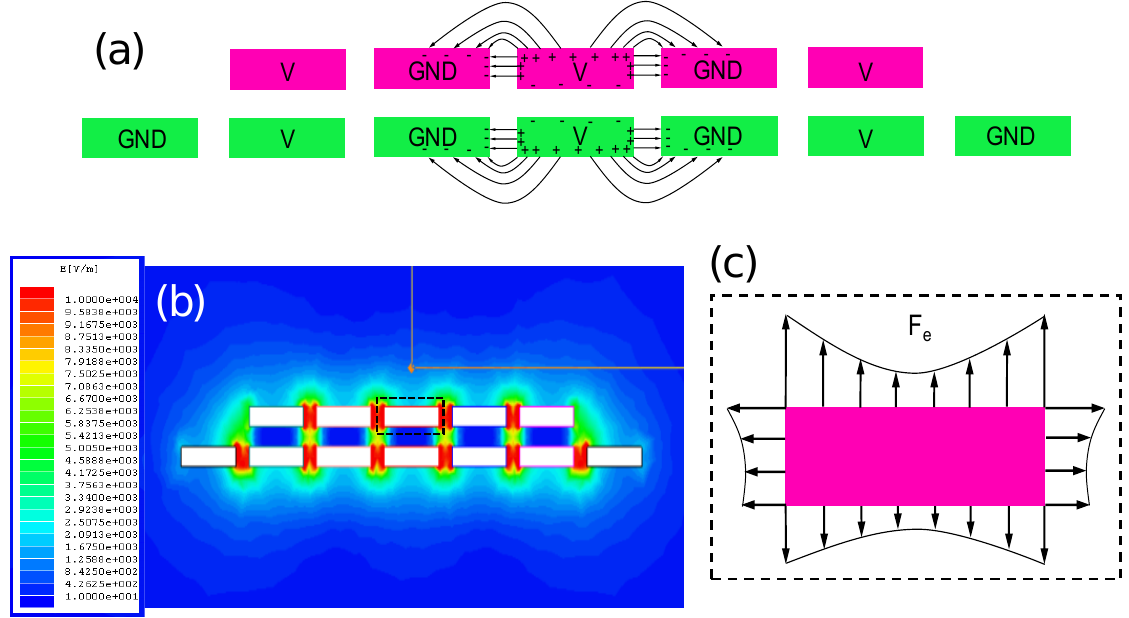
Figure 2. Schematic of generation of electrostatic repulsive force: ( a ) Arrangement of electrode and application of voltage on different electrodes to generate electrostatic repulsive force, here “V” indicate the application of a positive voltage to this electrode and “GND” means application of ground; ( b ) Simulated cross-sectional magnitude of the electrostatic field of the structure in this paper, when V = 100 Volts, based on simulation, schematic of electrical field distribution of the two central electrodes are given in Figure 2a; ( c ) Schematic of force distribution of the upper central electrode, as shown inside dashed